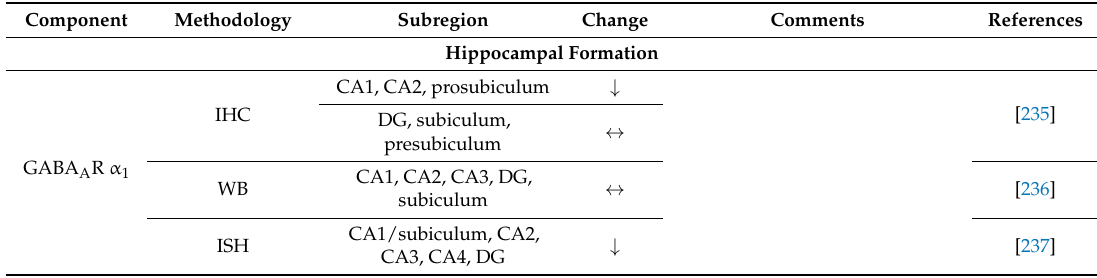
Table 2. Alterations in GABAergic signaling component expression in the human Alzheimer’s disease